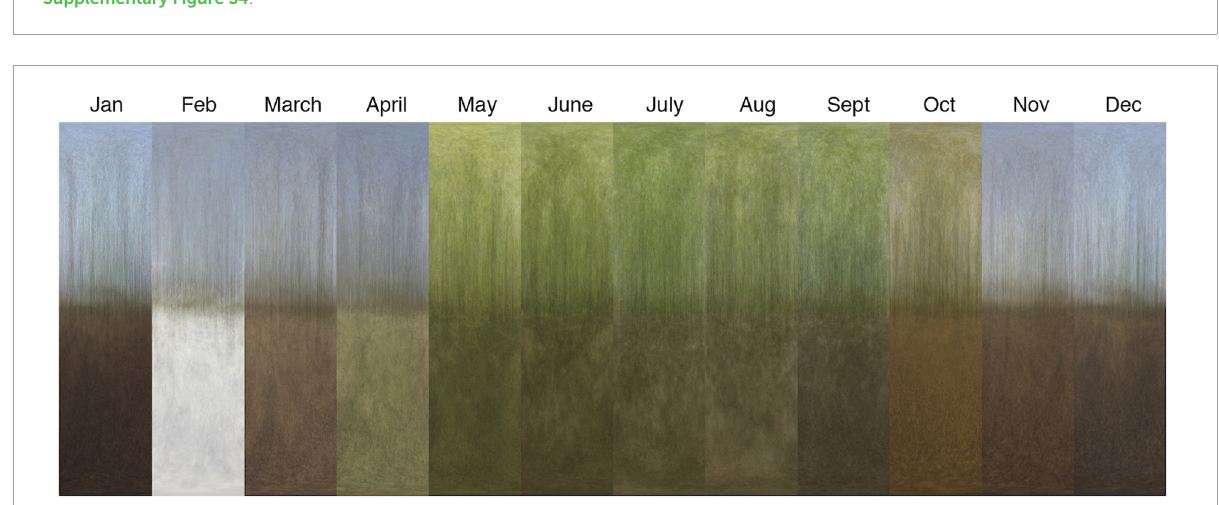
FIGURE7 Average images ( ± 90 ◦ elevation) of a beech-tree forest near Dalby, southern Sweden, sampled in clear sunny conditions each month of the year. The images were sampled randomly from a trail through the forest, resulting in 30–36 scenes contributing to each image. For these measurements, full results with light gradient graphs are found in Supplementary Figure S5